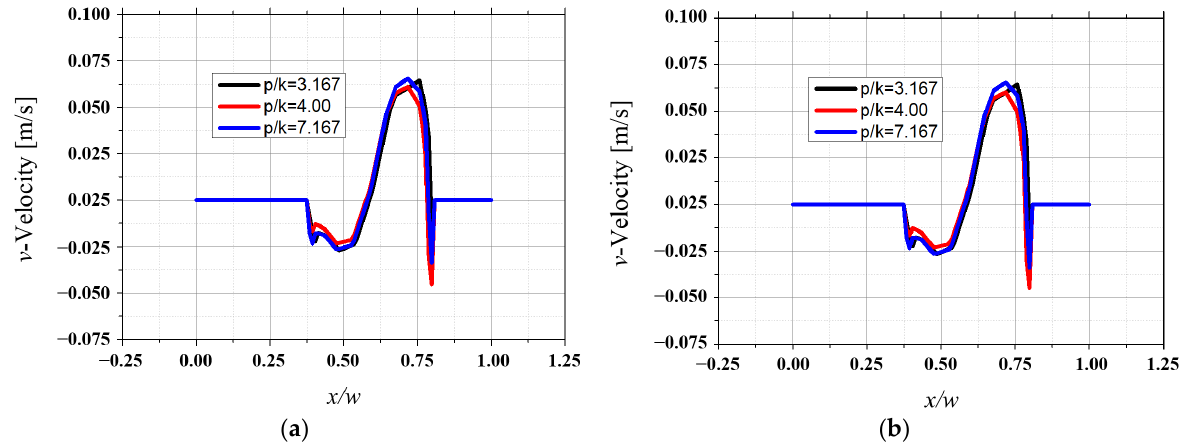
Figure 14. Comparison of v -velocity distribution at groove interface for different p / k : ( a ) Comparison of v -velocity distribution at 5th groove interface for different p / k , ( b ) Comparison of v -velocity distribution at 20th groove interface for different p / k .